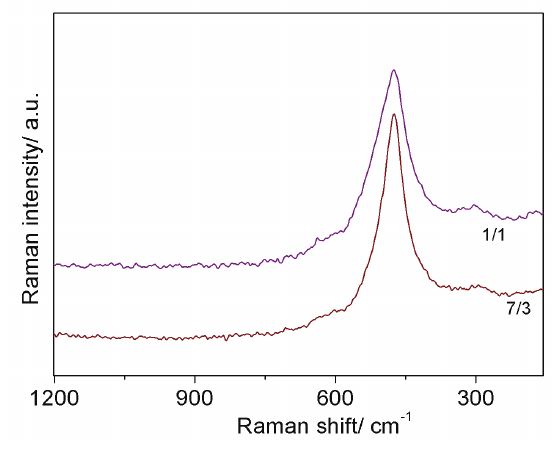
Figure 7a: Typical high resolution TEM image of nanodomains in 5Ni/Ce Zr O sample. 0.5 0.5 2